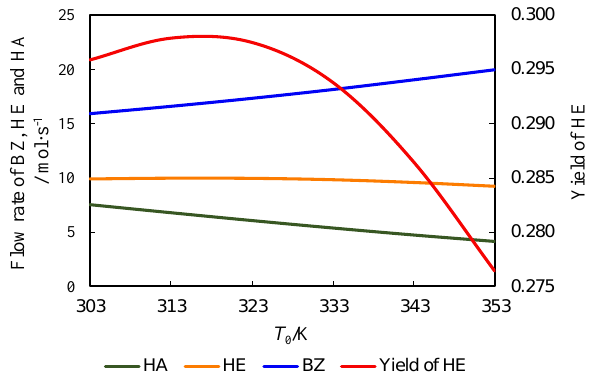
Figure 6. The flowrate variation of reactor effluent along the reactor temperature.